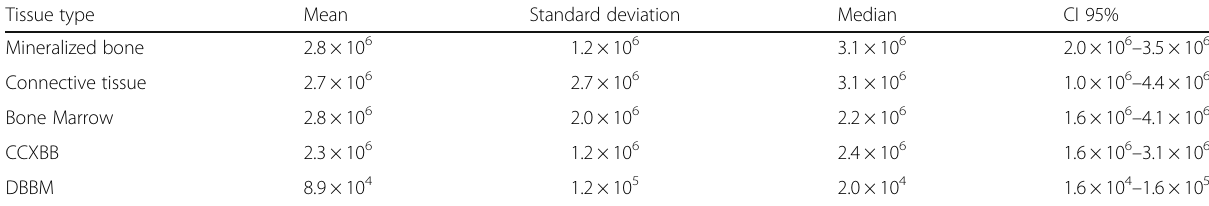
Table 2 Quantitative histological analysis Tissue type Mean Standard deviation Median CI 95% Mineralized